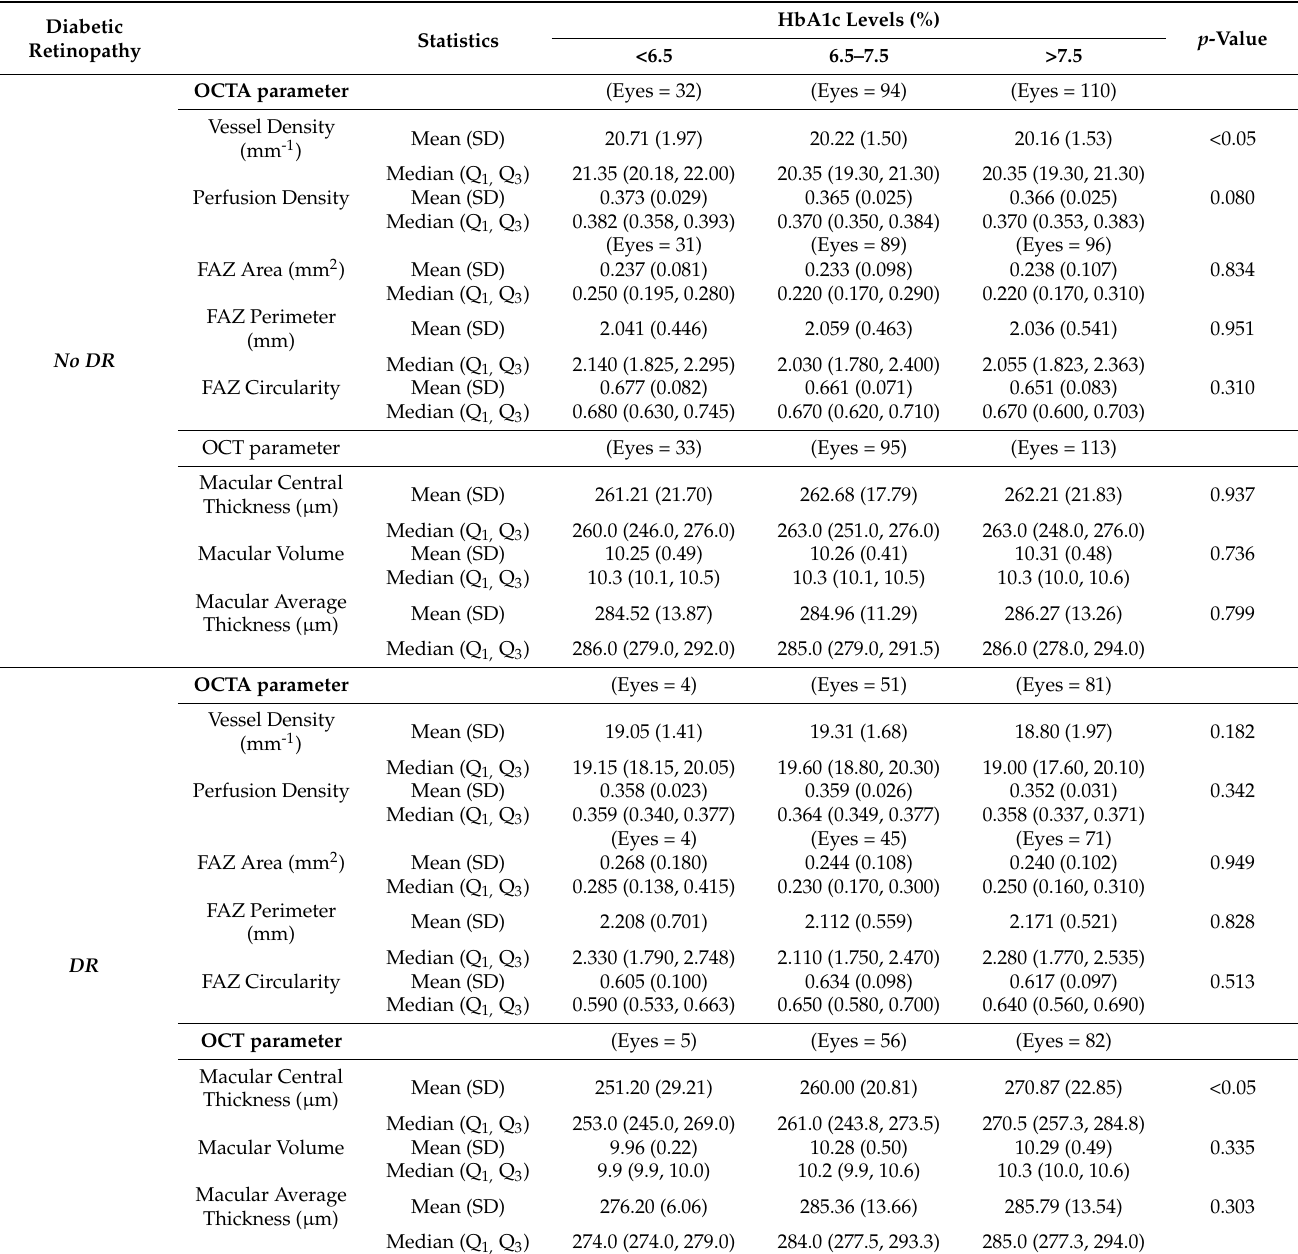
Table 2. Subgroup analysis by DR status and HbA1c